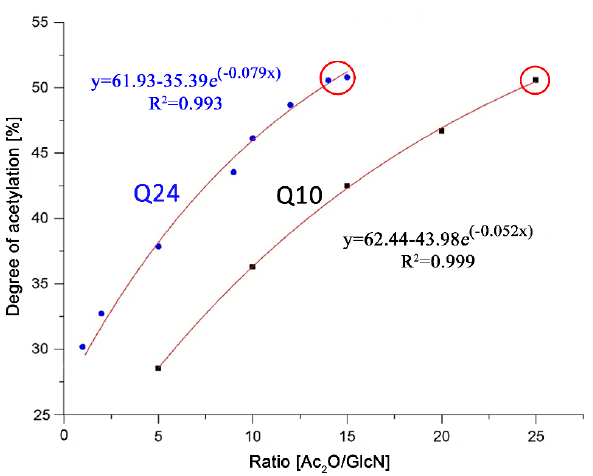
Figure 7. Relationship between the Ac 2 O/GlcN molar ratio and the DA of the acetylated chitosans Q10 and Q24 (data in circles correspond to partially insoluble products).